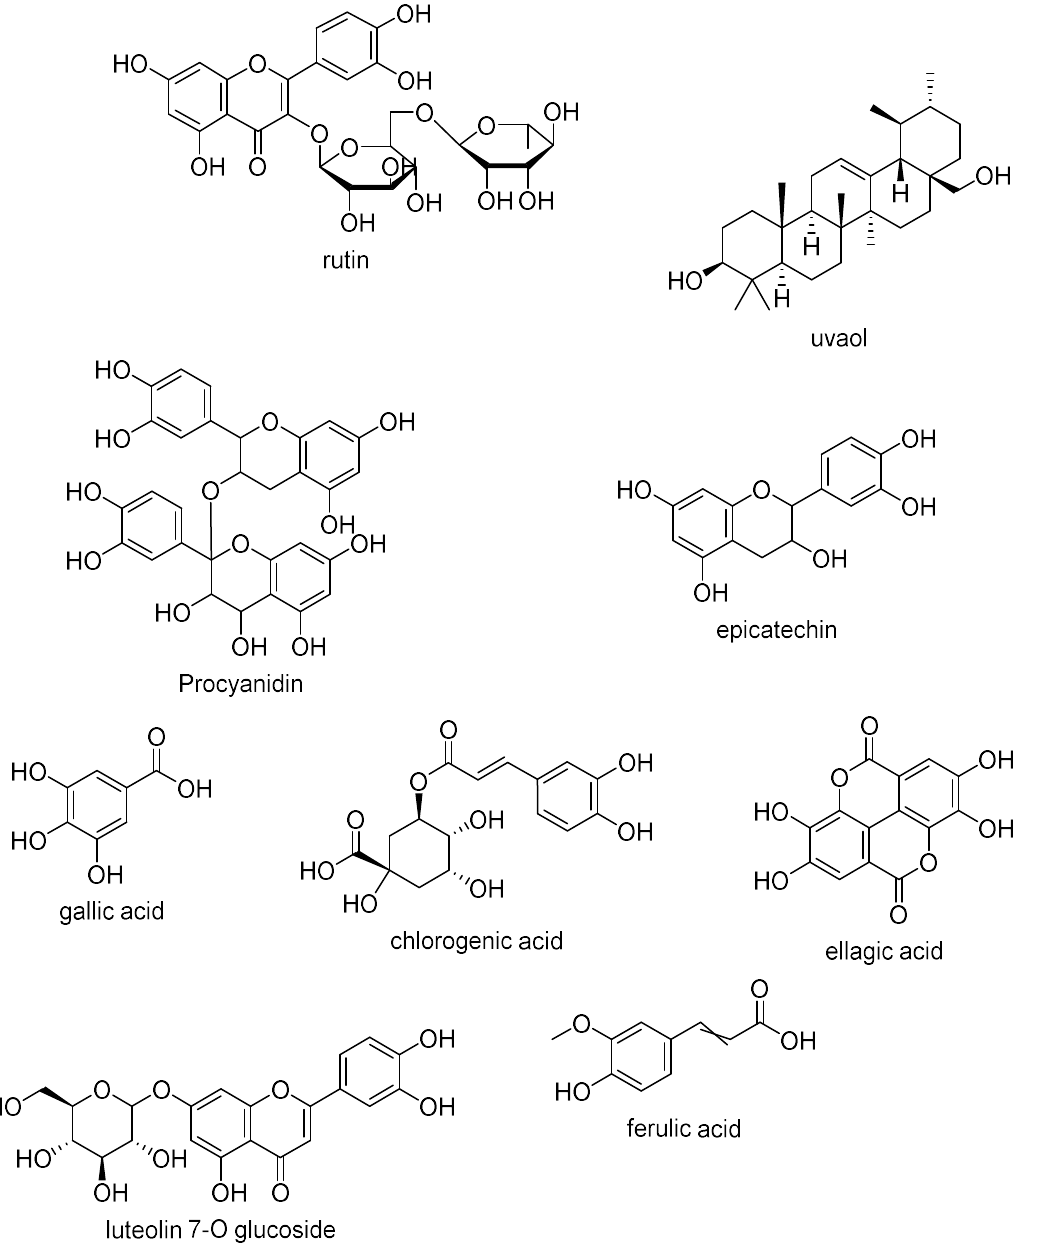
Figure 2. Some selected structures of phytochemicals identified in Carpobrotus edulis [43]